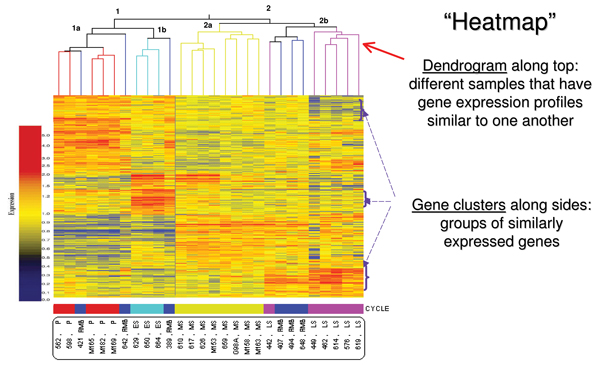
Gene clustering in the endometrium: Gene expression profiling across the menstrual cycle. The Heatmap represents relative gene expression levels in the endometrial samples across the menstrual cycle. Each horizontal line represents a single gene, and each column represents a single sample. Samples cluster by cycle phase (bar at bottom of the Heatmap: proliferative (red), early-secretory (light blue), mid-secretory (olive), late secretory (purple) and ambiguous samples (dark blue). Relative expression of each gene is color-coded: high (red) or low (blue), as indicated in the color legend on the left side of the figure. Hierarchical clustering reveals sample clustering into cycle phases and unique molecular profiles. Adapted from [14], with permission.